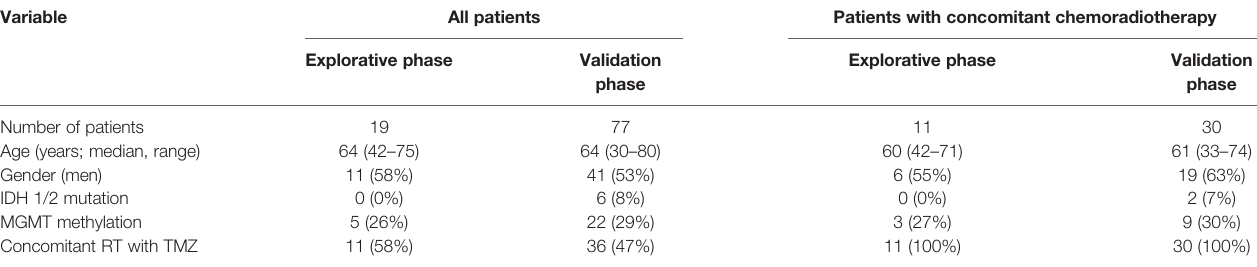
TABLE 1 | Clinical, histopathological, and molecular characteristics of patients included in the study.